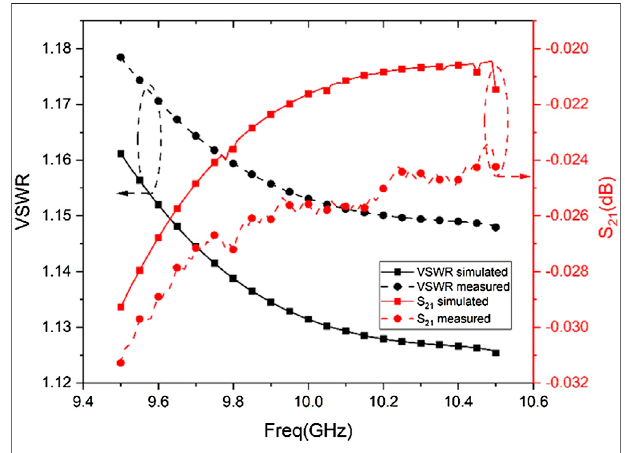
FIGURE 9 | S 21 and VSWR of TM 01 mode.